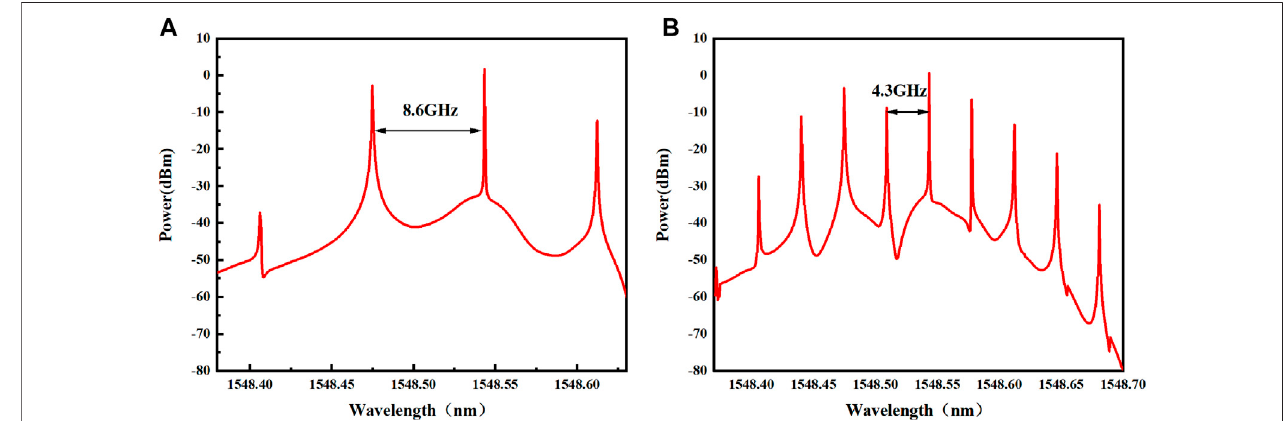
FIGURE 2 | (A) Primary seed OFC. (B) Subharmonic-locked OFC obtained by